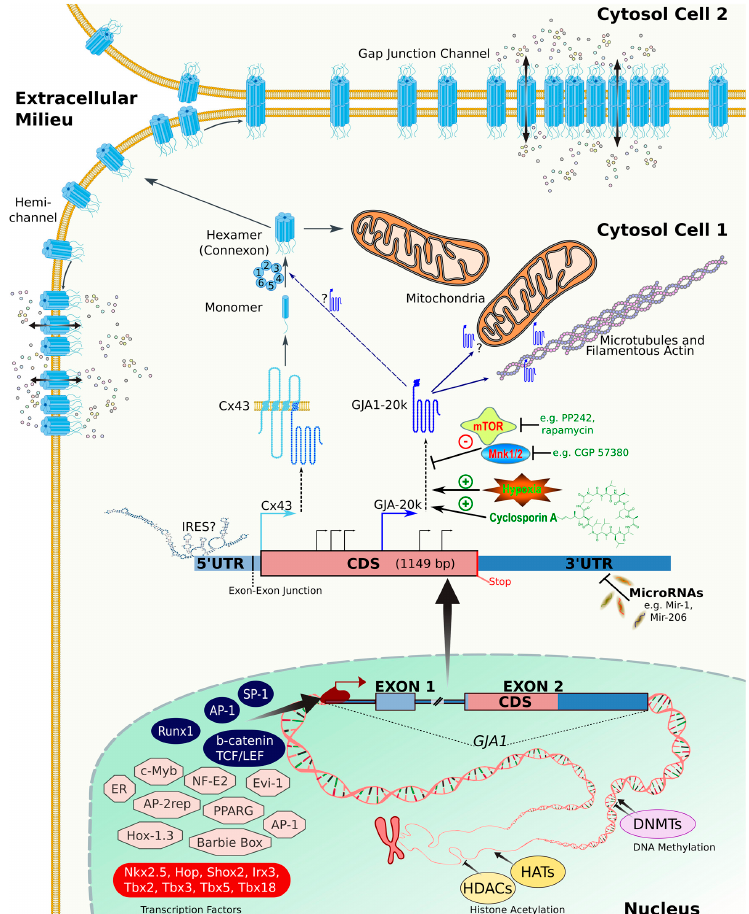
Figure 1. Connexins form hexameric connexons permeable to small molecules acting either as hemichannels or as intercellular channels. The human GJA1 gene, encoding for connexin 43 (Cx43), contains two exons spanning a genomic region of 14,168 bp. Exon 1 contains 256 bp of the 5 (cid:48) UTR (untranslated region), whereas exon 2 encompasses 16 bp of the 5 (cid:48) UTR, the entire coding region (1149 bp), and the entire 3 (cid:48) UTR region (1748 bp). Transcription of mRNA (3169 bp) is under regulation by numerous transcription factors as indicated in this figure and in the main text. Notably, Sp-1 and AP-1 are key regulators of Cx43 mRNA expression (grouped in blue). Multiple tissue-specific promoters are active, which has been well described in the heart (grouped in red). Additional transcription factors (grouped in light red) are derived from promoter analysis using the online Lasagna-Search tool (using a very strict cut-off of p < 0.0001 and Transfac transcription factor binding sites) [13]. Epigenetics regulate transcription, including through promoter hypermethylation by DNA methyltransferase enzymes (DNMTs). Acetylation by histone acetyltransferase enzymes (HATs) promote transcription, and the reverse reaction is mediated by histone deacetylases (HDACs). The transcript is also regulated by numerous microRNAs (see main text for details). In addition to full-length Cx43 (43 kilodalton (kDa)), the same mRNA can produce multiple truncated forms via internal translation initiation (indicated by arrows within the CDS (coding DNA sequence) of the mRNA, most notably the 20 kDa form named GJA1-20k). Truncated forms are also under translational regulation by a number of pathways such as mechanistic target of rapamycin (mTOR) and mitogen-activated protein kinase (MAPK)-interacting serine/threonine-protein kinase 1 (MNK1) and 2 (MNK2), and can be induced by inhibitors of these pathways as well as by other specific drugs such as cyclosporin A (the positive regulators are depicted in green). GJA1-20k is also induced by pathological states such as hypoxia. The function of GJA1-20k may include interaction with mitochondria and regulation of the actin cytoskeleton as well as regulation of Cx43 oligomerization and trafficking to the membrane. See main text for further details related to the